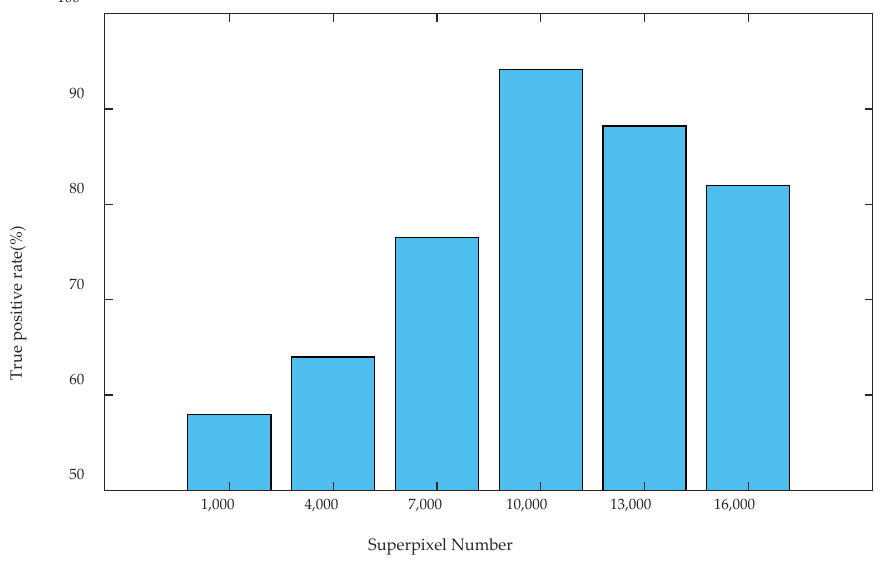
Figure 3. Selection of the number of superpixels.